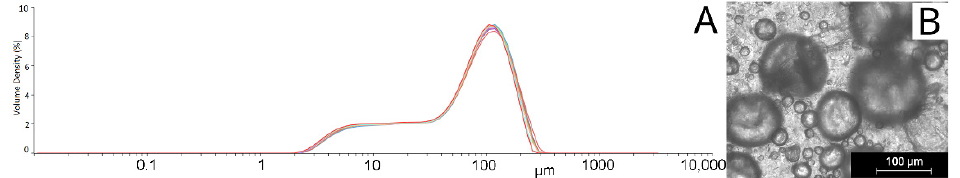
Figure 2. Static light scattering analysis of solid lipid particles (SLP) in suspension GEN_1.5 ( A ) SLP size distribution, and ( B ) SLP before immobilization.